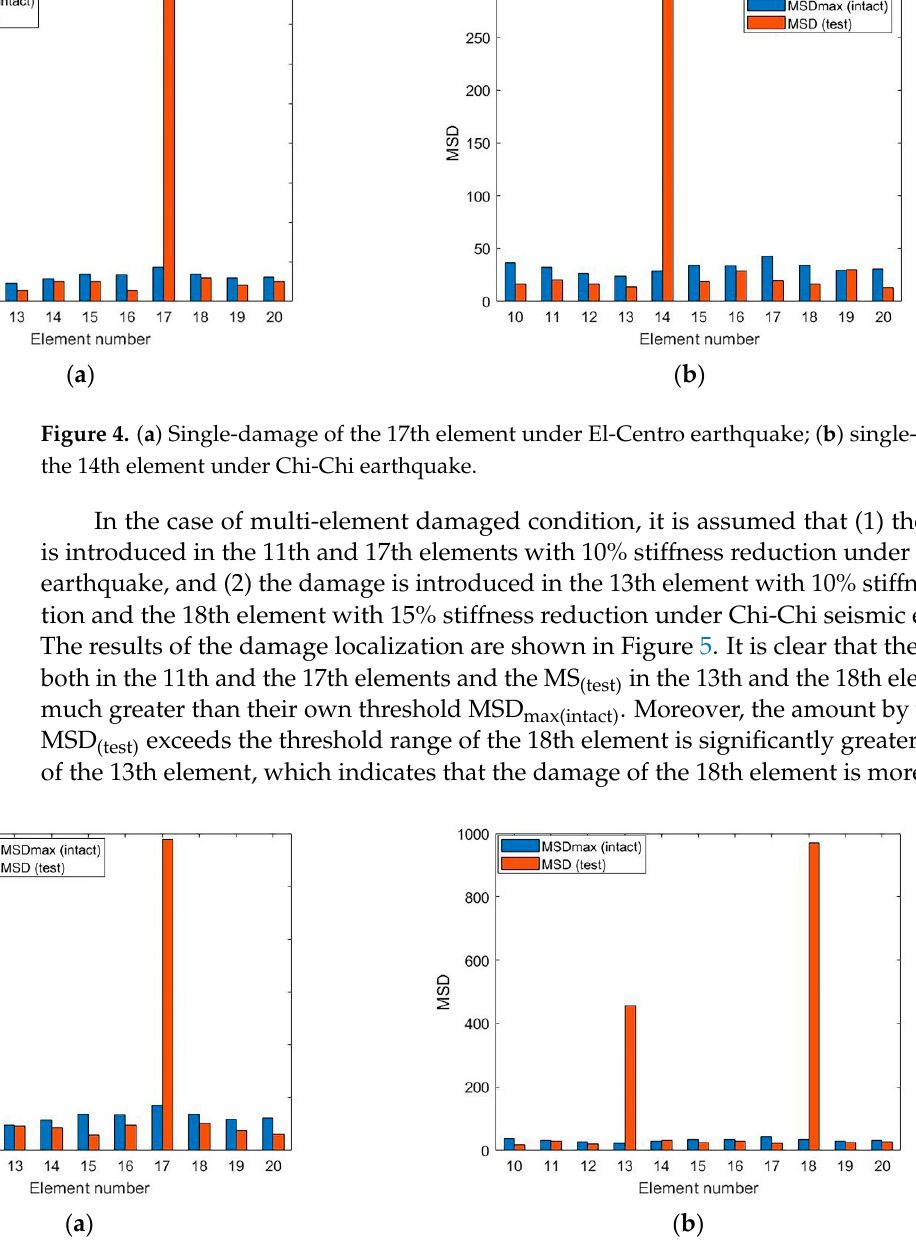
Figure 5. ( a ) Multi-damage of the 11th and 17th elements under El-Centro earthquake; ( b ) multi- damage of the 13th and 18th elements under Chi-Chi earthquake.